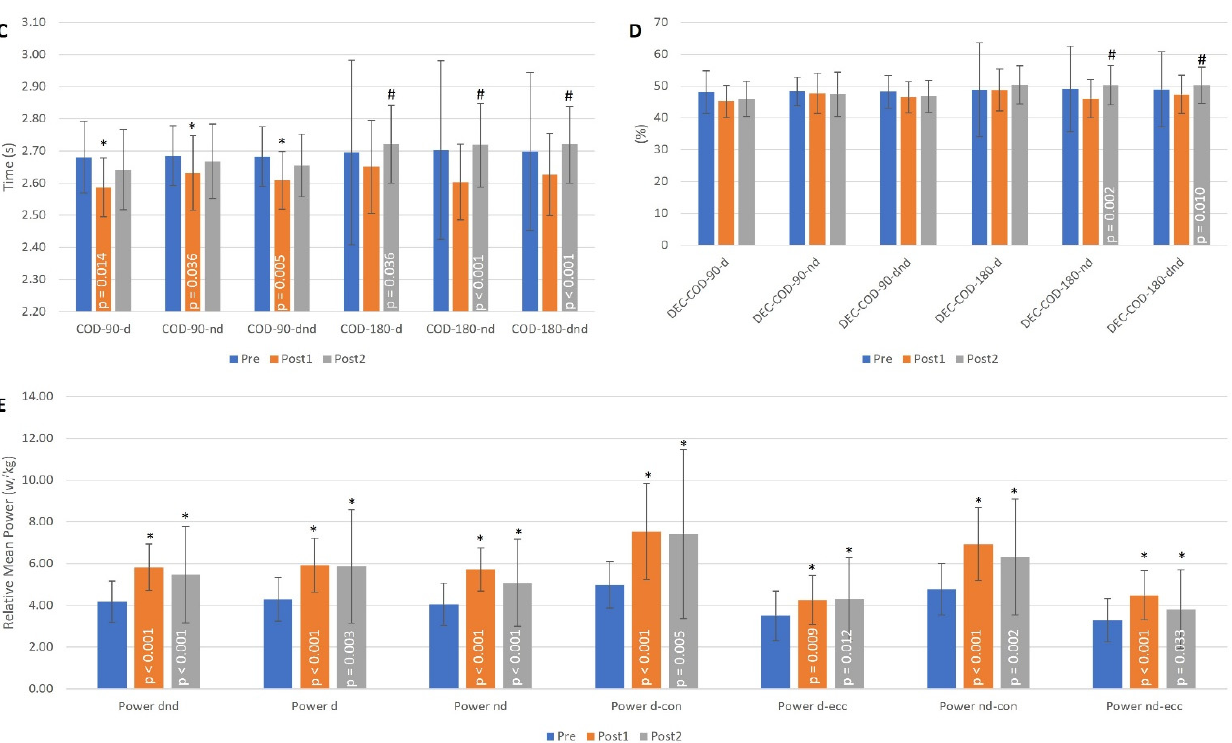
Figure 3. Evolution of CMJ ( A ), 30 m ( B ), COD ( C ), DEC-COD ( D ) and laboratory ( E ) variables during pre, post-1 and post-2 tests. (*) Different from the pre-test at p < 0.05; (#) Different from the post-1 test at p < 0.05. Abbreviations: CMJ, countermovement jump height; TT 30 m, 30 m total sprint time 30 m; COD, change of direction; DEC, percentage decrement respect 10 m; d, dominant leg; nd, non-dominant leg; dnd, mean value of both legs; con, concentric action; ecc, eccentric action.